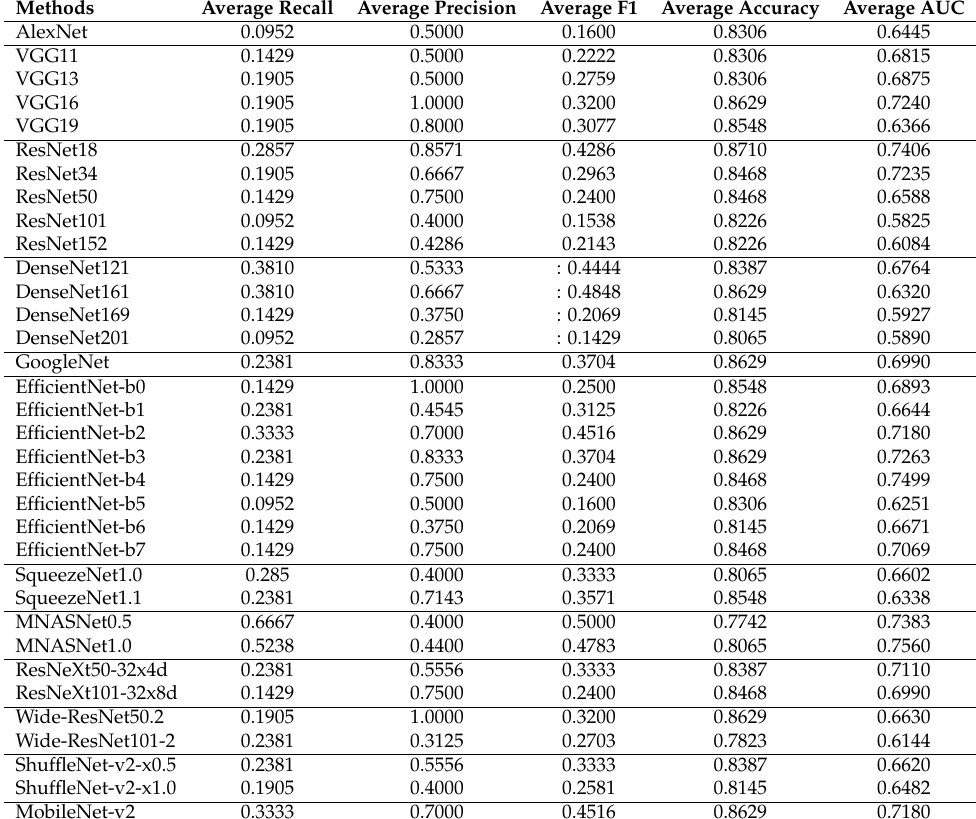
Table 2. Quantitative results for state-of-the-art deep learning algorithms on COVIDx. The numbers at the end of the method name indicate variants of the same algorithms.